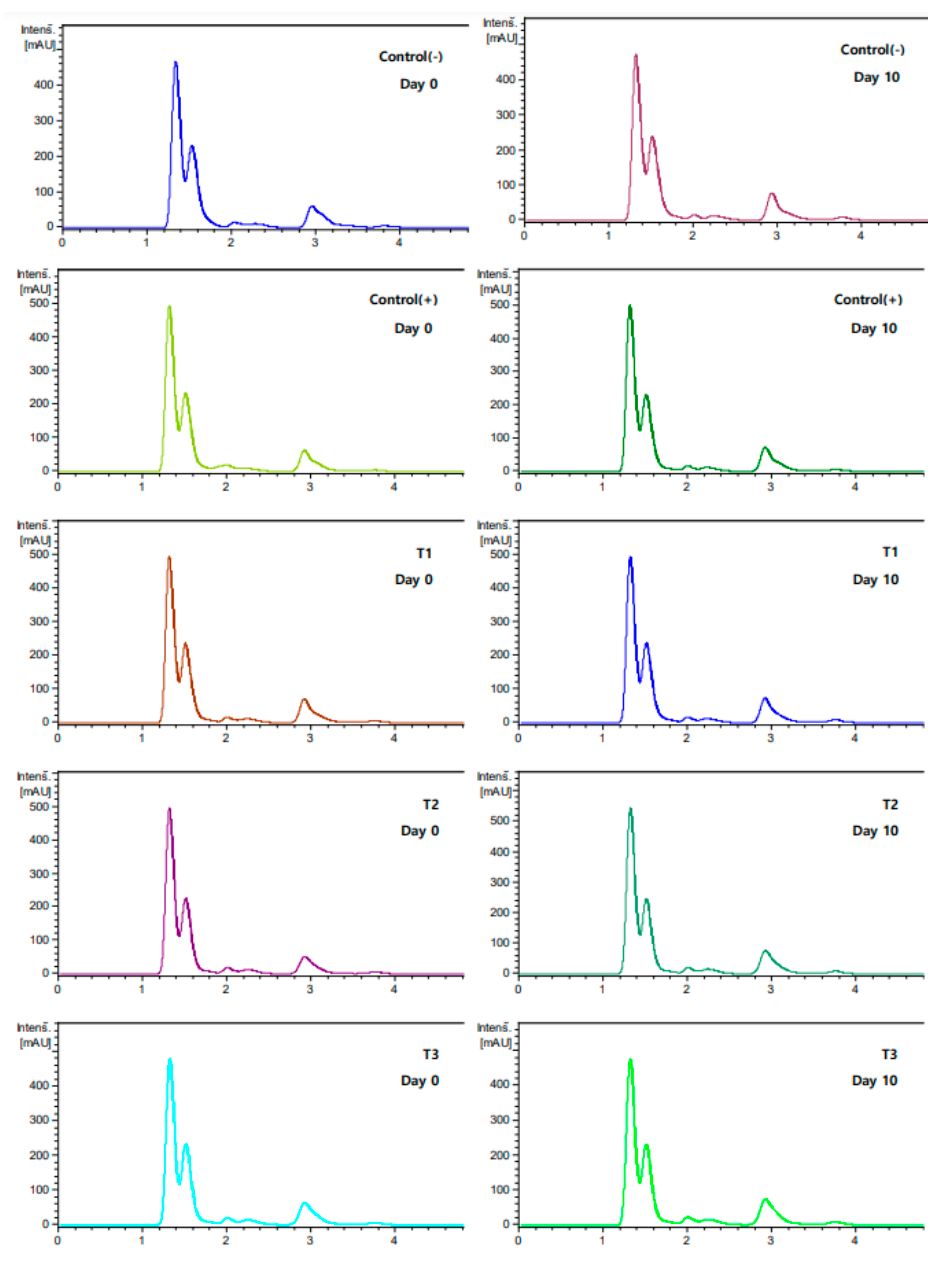
Figure 4. Chromatogram of the samples of the organic acids.